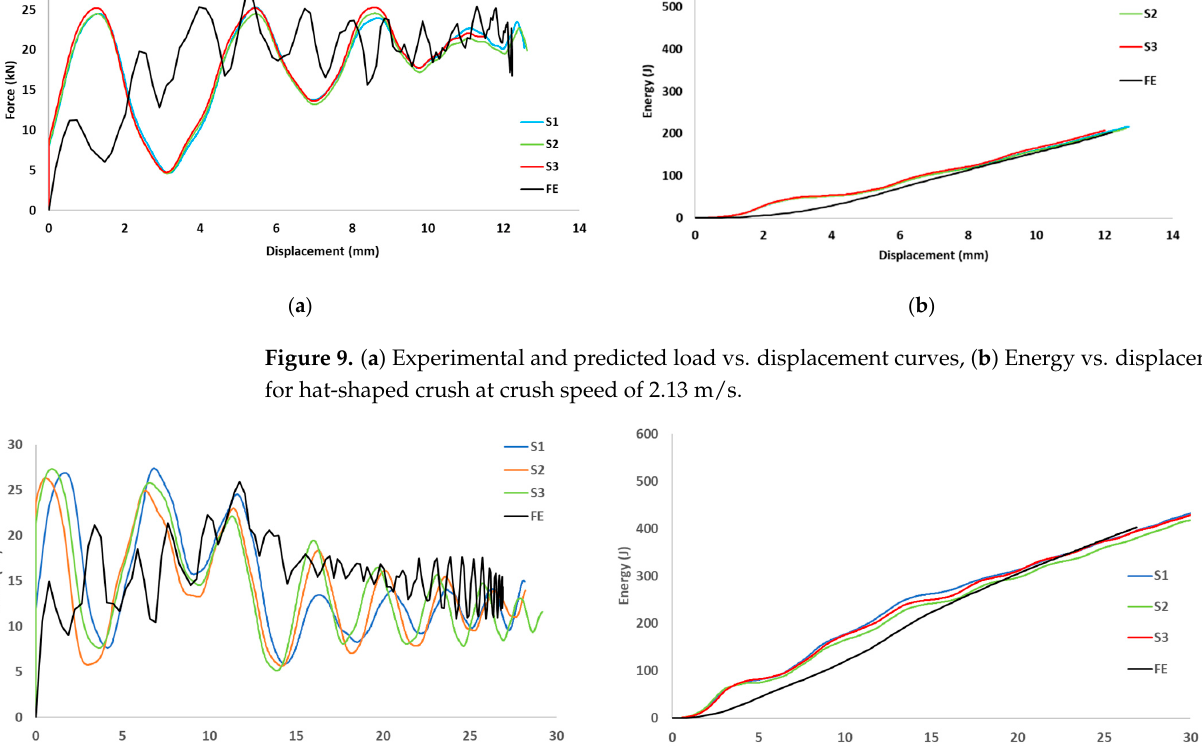
( b ) Figure 11. ( a ) Experimental and predicted load vs. displacement curves, ( b ) Energy vs. displacement for hat-shaped crush at crush speed of 3.5 m/s. Figure 12 shows a comparison between the experimental and predicted results of the composite closed-top hat subjected to different transverse dynamic speeds. The figure shows good agreement between the experimental and predicted results from the FE model, and the behaviors of both appear to be consistent. The predicted results, experi- mental results, and the differences between them are listed in Table 3.